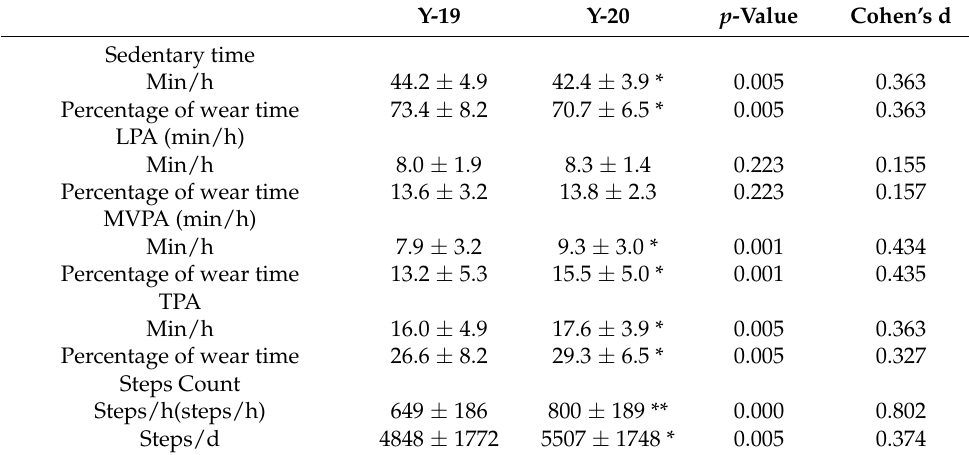
Table 5. Physical activity in preschool children during time spent in childcare and as a percent of time spent in childcare before and during the COVID-19 pandemic. Y-19